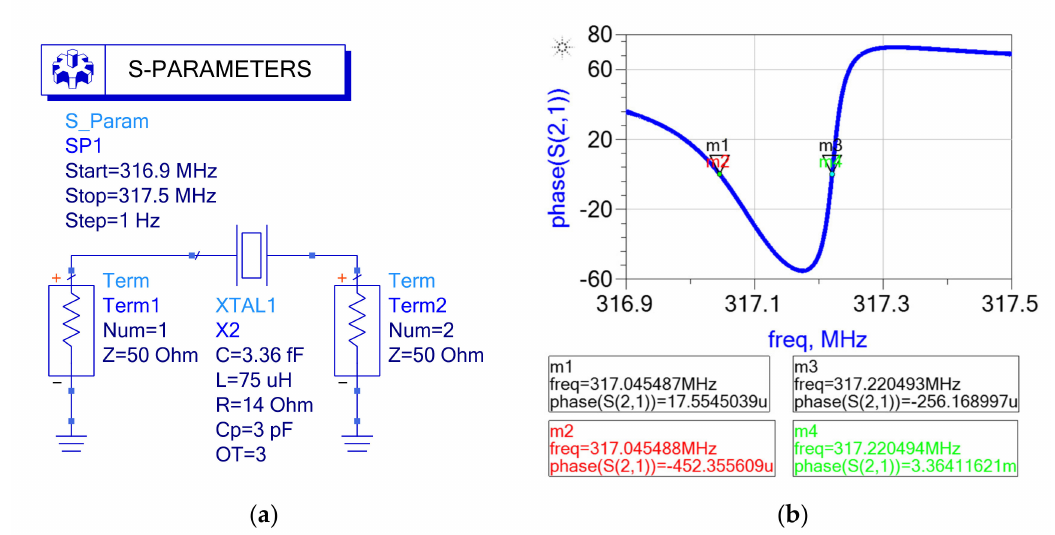
Figure 2. Simulation schematic diagram and result: ( a ) schematic diagram; ( b ) phase–frequency curve of quartz crystal ADS